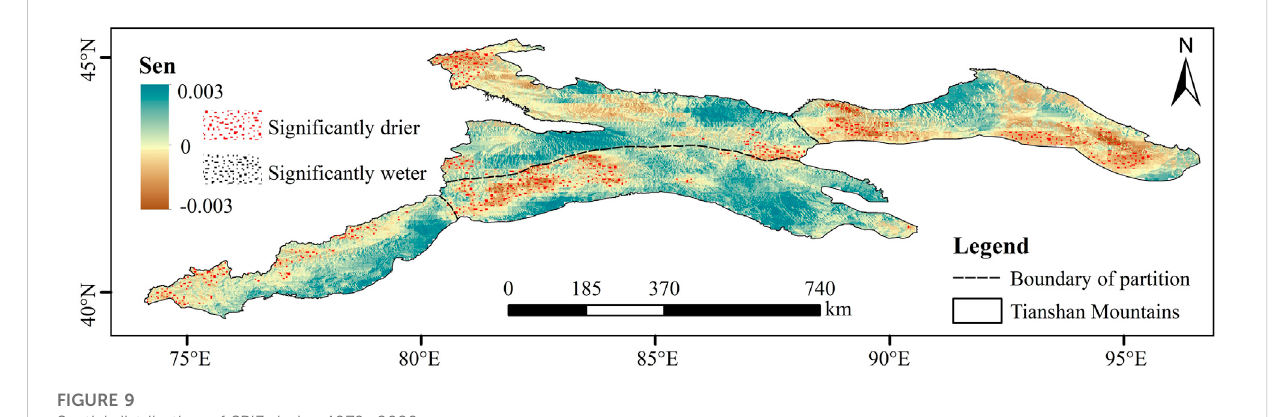
FIGURE 9 Spatial distribution of SPI3 during 1979 –